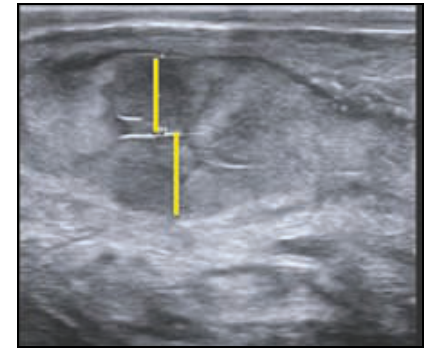
diameter2b. Endometrial